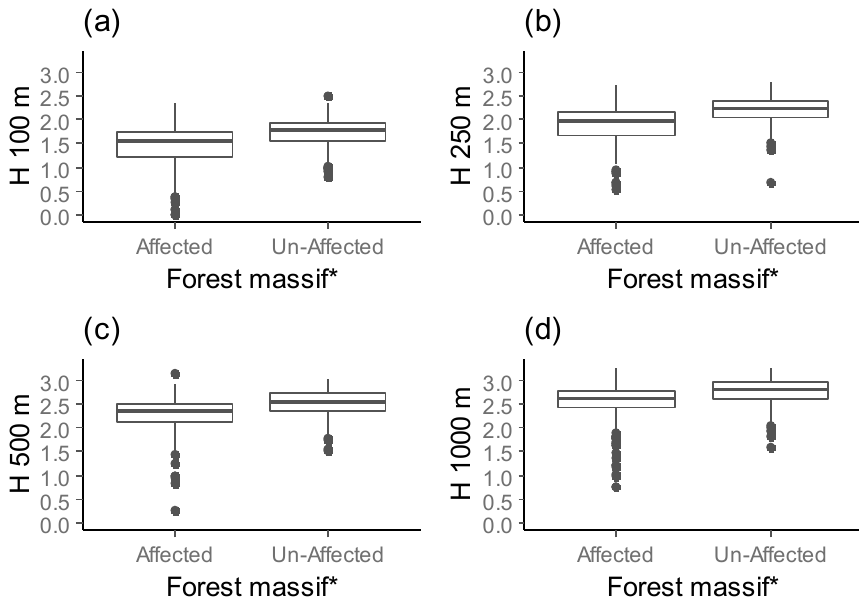
Figure 5. The forest diversity surrounding selected Norway spruce stands within different buffer radii (( a ) H 100, ( b ) H 250, ( c ) H 500, ( d ) H 1000) for affected and unaffected forest massifs (* indicate significant difference using Kruskal-Wallis test; overall significance level = 0.05).